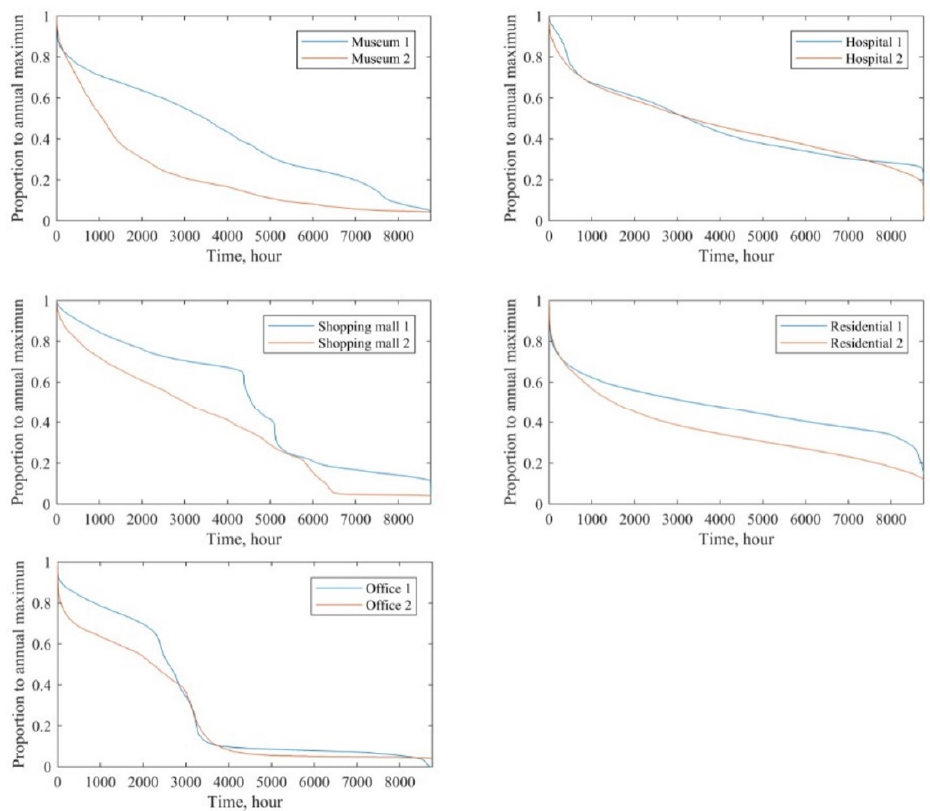
Figure 3. Annual 8760-h power load of the museums, hospitals, shopping malls, residential buildings, and office buildings.